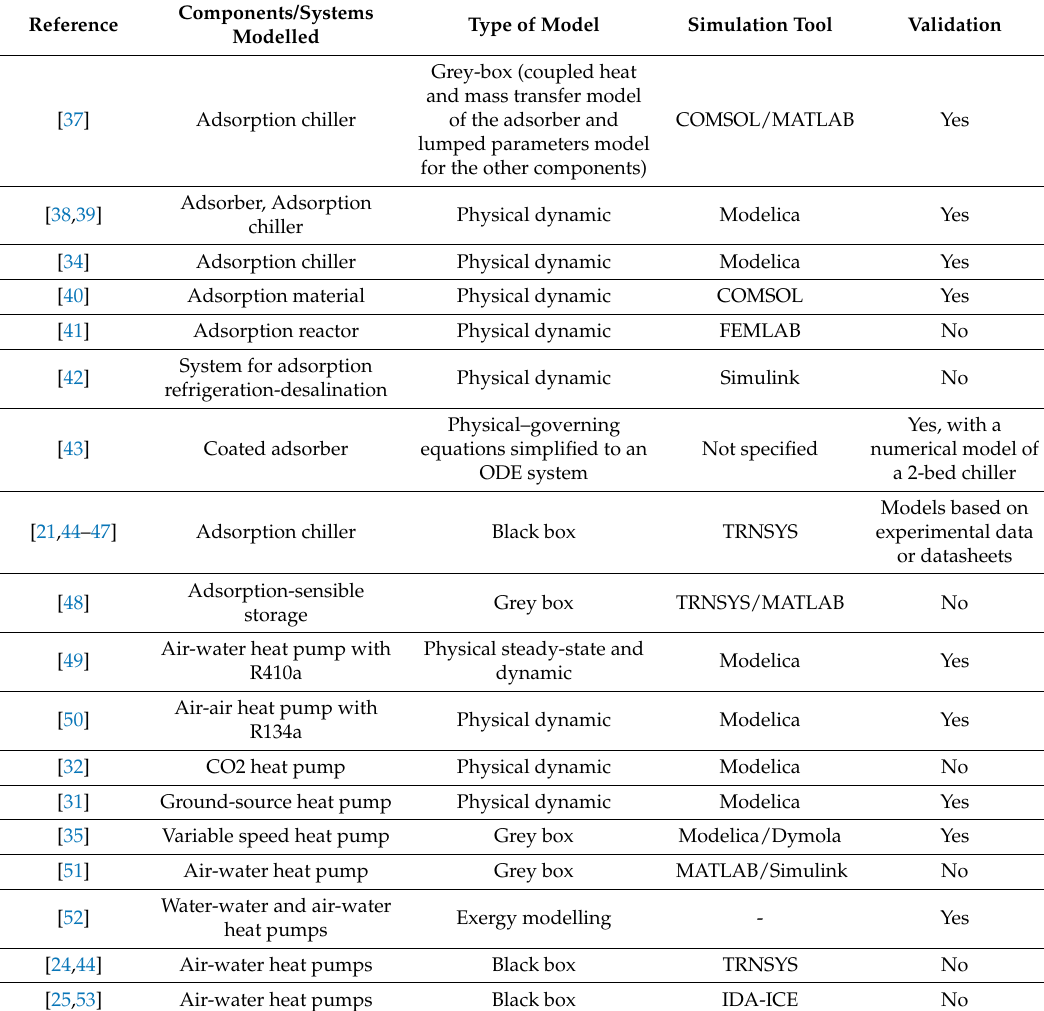
Table 1. Models of adsorption components and vapour compression heat pumps published in